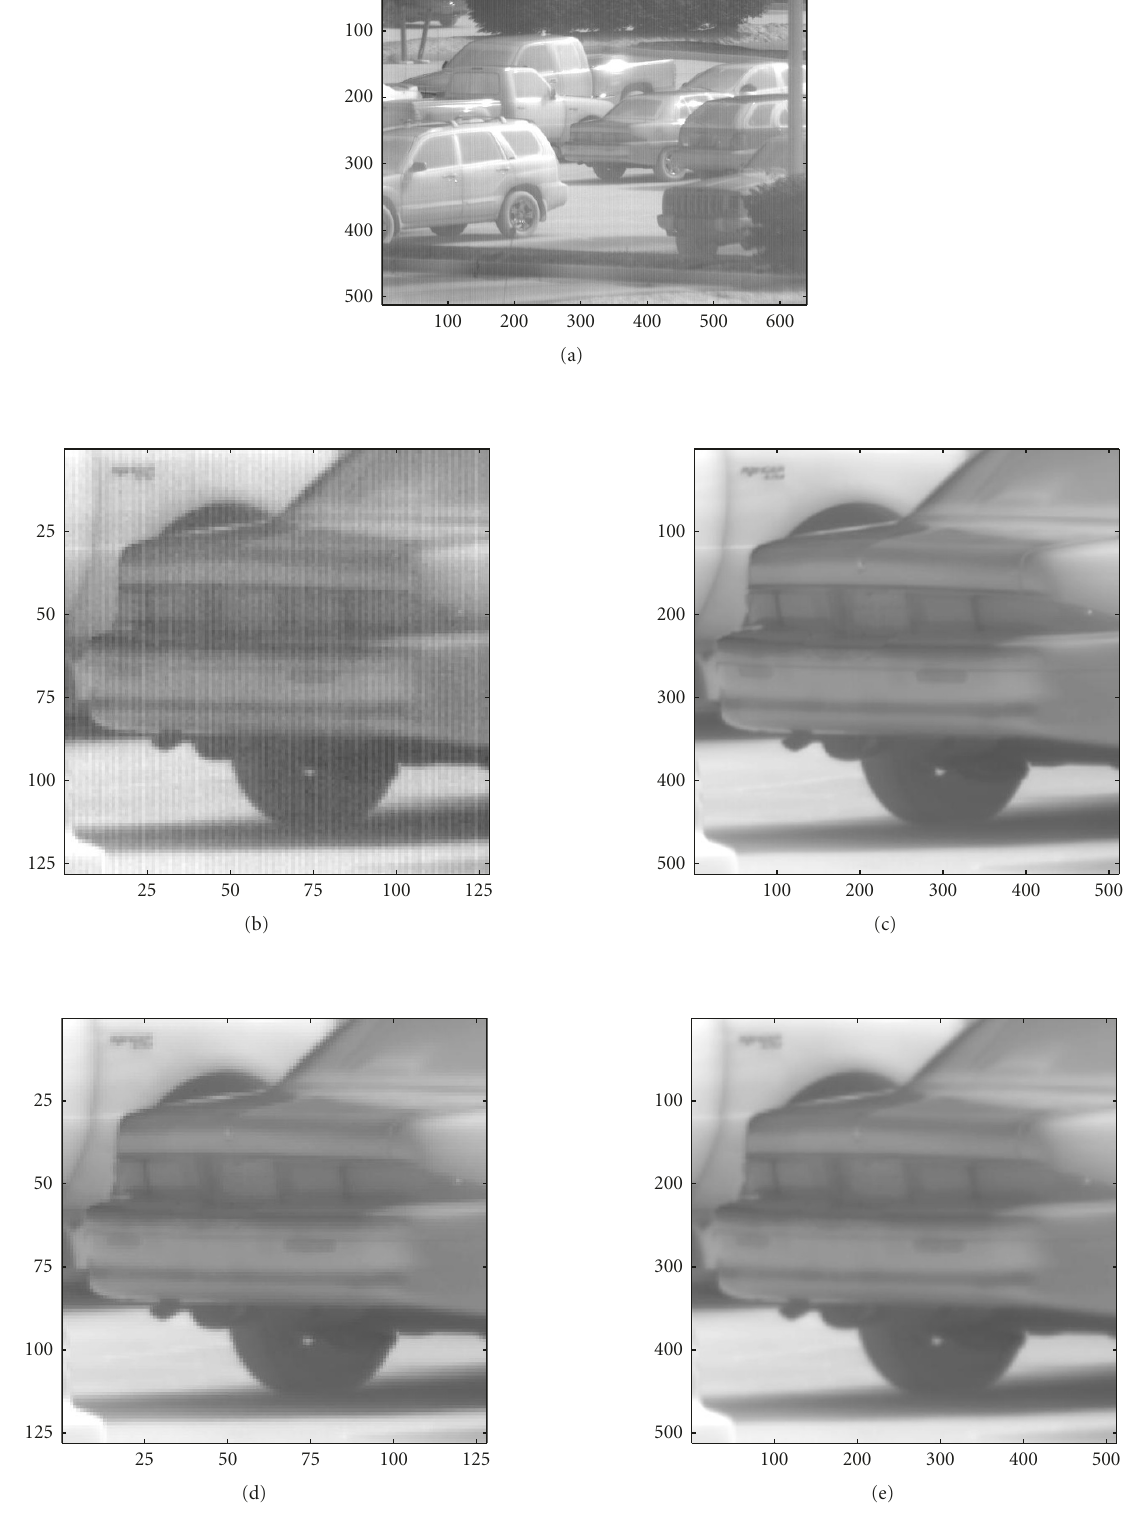
Figure 7: Simulated image results: (a) observed frame-one low-resolution image; (b) observed frame-one low-resolution image region of interest; (c) frame-one region of interest restored using the MAP SR-NUC algorithm for P = 20 frames; (d) frame-one region of interest corrected with the MAP SR-NUC biases for P = 20 frames; (e) low-resolution corrected region of interest followed by bilinear